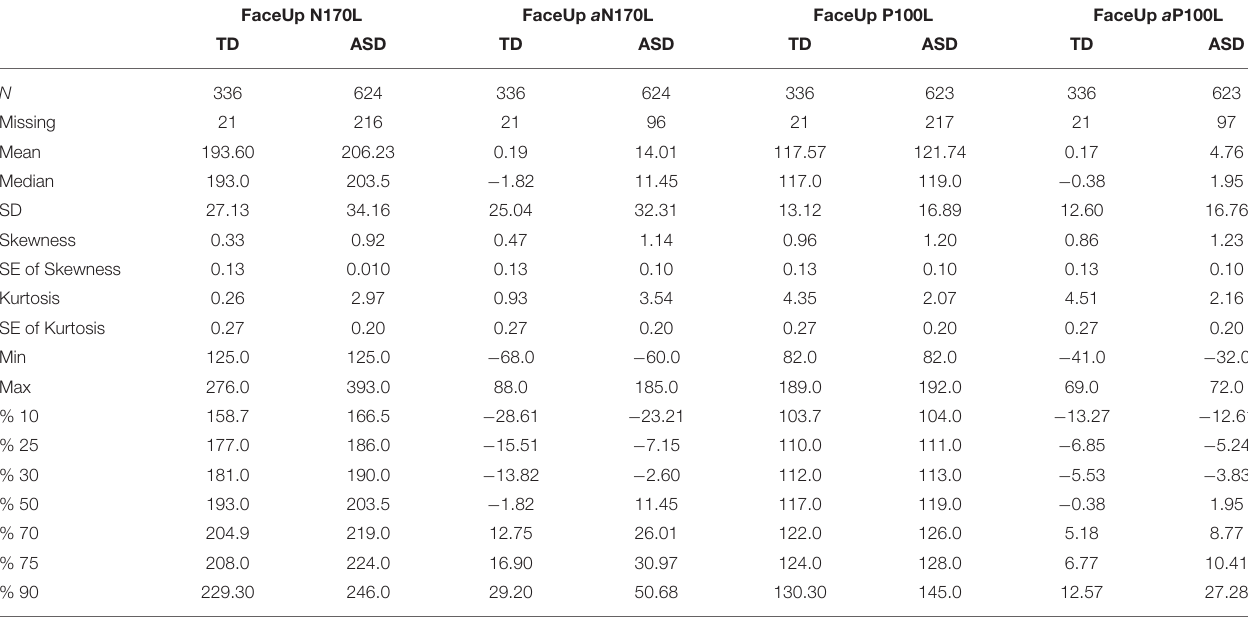
TABLE 2 | Summary statistics for raw and residualized N170L and P100L in response to upright faces.